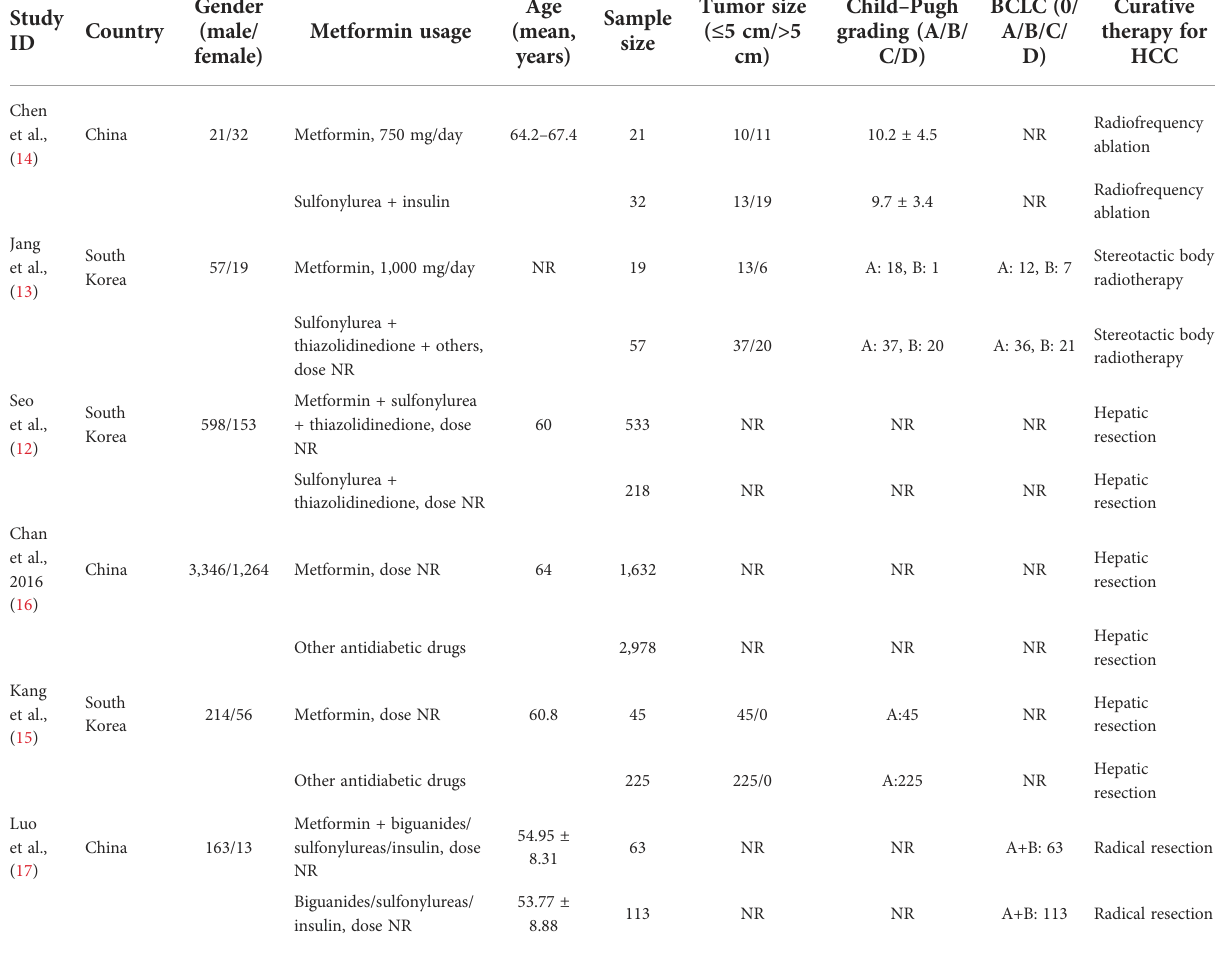
TABLE 1 The characteristics of the included